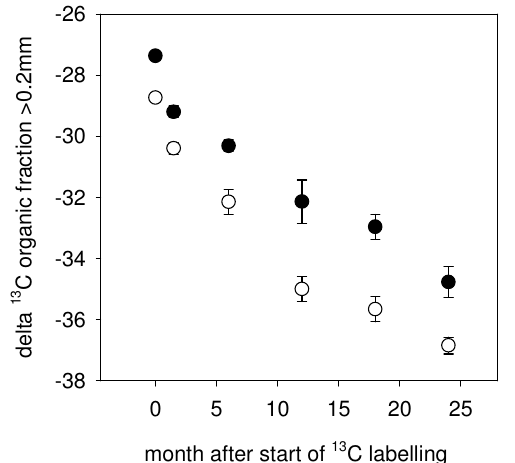
month after start of 13 C labelling Fig. 3. Changes of the δ 13 C of total soil organic matter above 0.2mm (SOM > 0.2mm, including roots, rhizomes and particulate organic matter) in the top soil (0–10cm) during the labelling ex- periment. Monoliths acclimated to low (solid symbols) and to high (open symbols) field disturbance. Data are means ± SE of 8 repli- Figure 3 cate mesocosms. Fig. 4. Changes in the contents (mg C g − 1 dry soil) of “old” (A) and “new” C (B) in the SOM above 0.2mm of the top soil (0–10cm) layer after start of 13 C labelling, for monoliths acclimated for 14yrs to low (full symbols) and high (open symbols) disturbance in the field. The fate of “old” C and the input of “new” C were fitted to first order exponential decay and rise to maximum models, respectively: 0 .t C old = a.e − k.t ; C new = a 0 .( 1 − e − k ) (abbreviations and coefficients of regression lines see Table